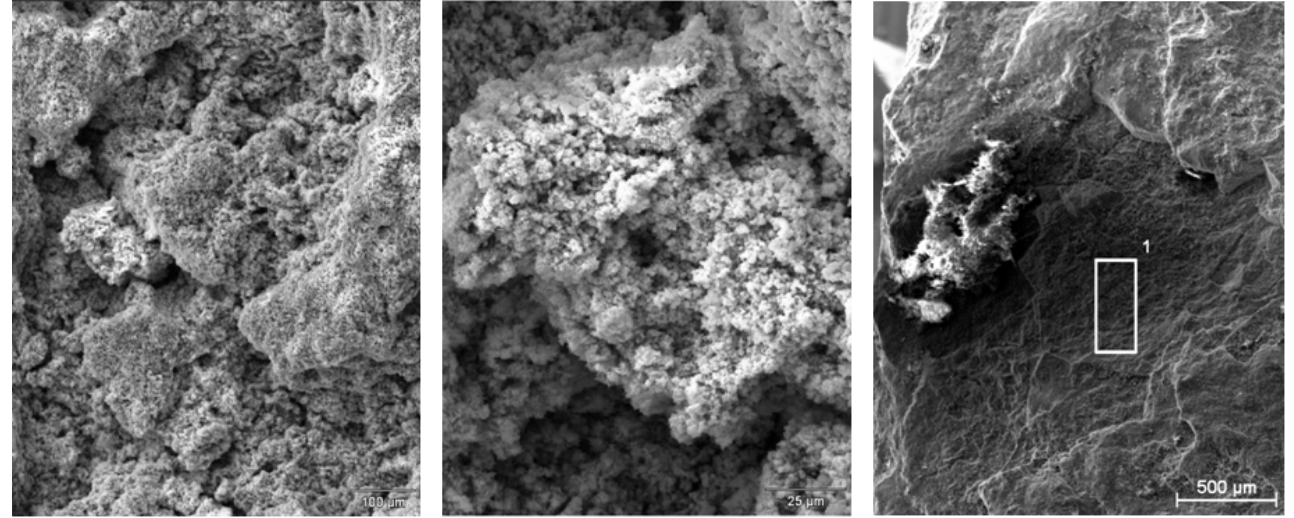
Figure 10: SEM analysis. Surface of the pit valley – 200 X.